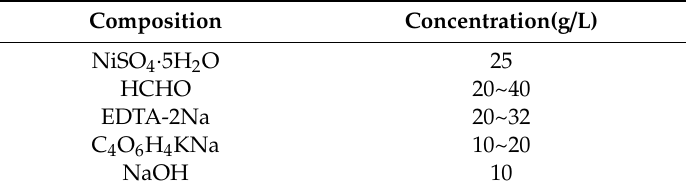
Table 1. Chemical composition of the copper plating